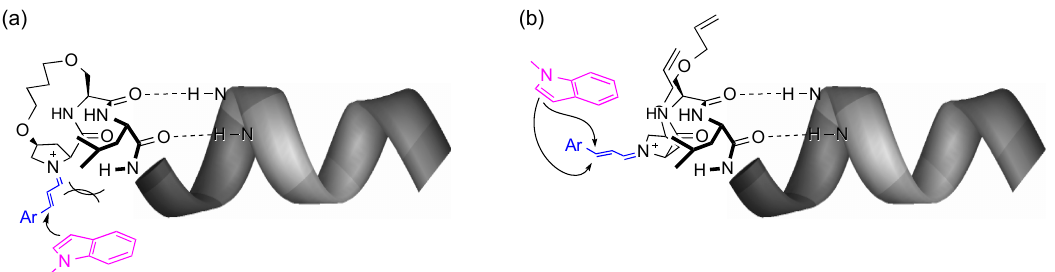
Figure 3. A plausible reaction mechanism catalyzed by ( a ) stapled peptide B’ and ( b ) unstapled peptide B .